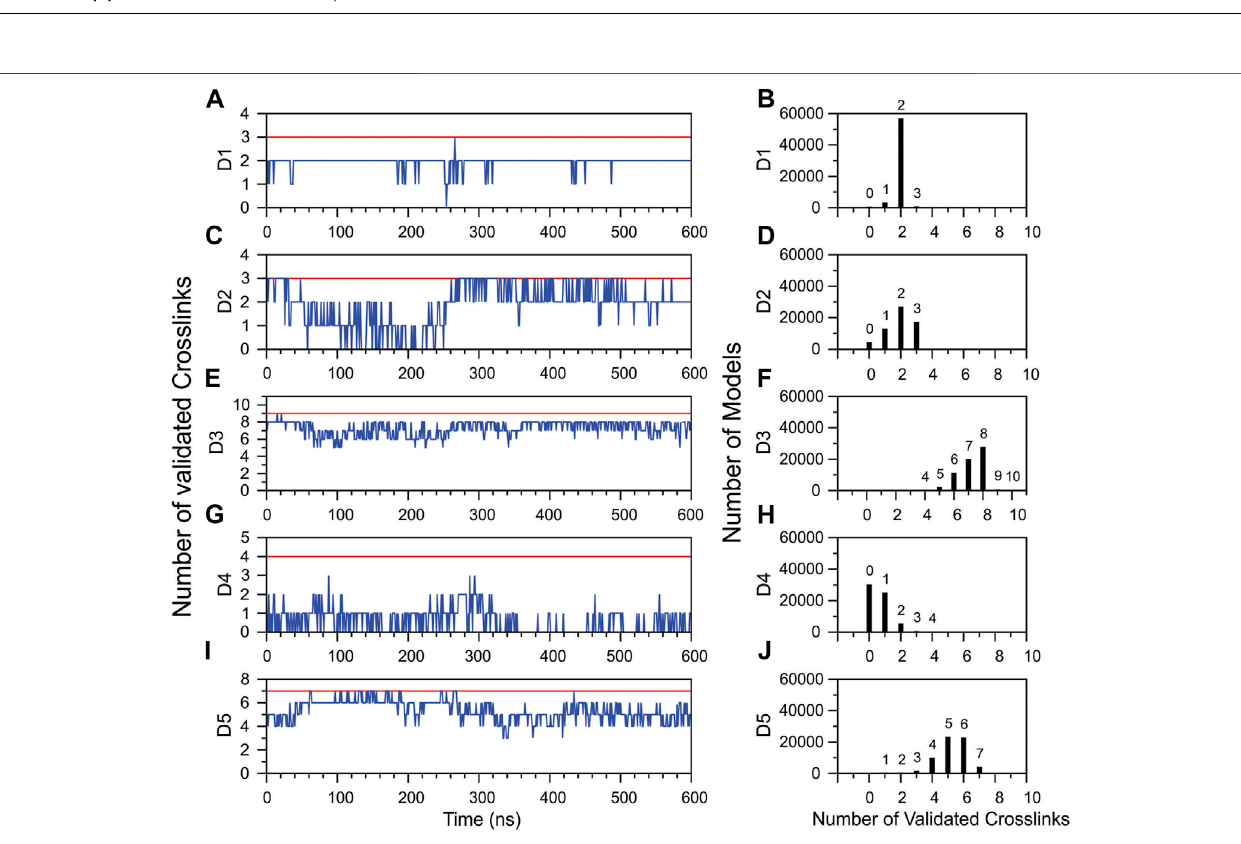
FIGURE 10 | Topological validation of the cross-linking results within each Ig-like domain of DM64 during the molecular dynamics simulation of DM64-myotoxin II complex. On the left (A,C,E,G,I) , the blue line represents the average number of validations calculated over 100 frames as a function of simulation time. The red line indicates the maximum number of validated crosslinks identi fi ed in the DM64-myotoxin II docking model. On the right (B,D,F,H,J) , distribution of the total number of models produced in the MD simulation as a function of the number of validated cross-links.